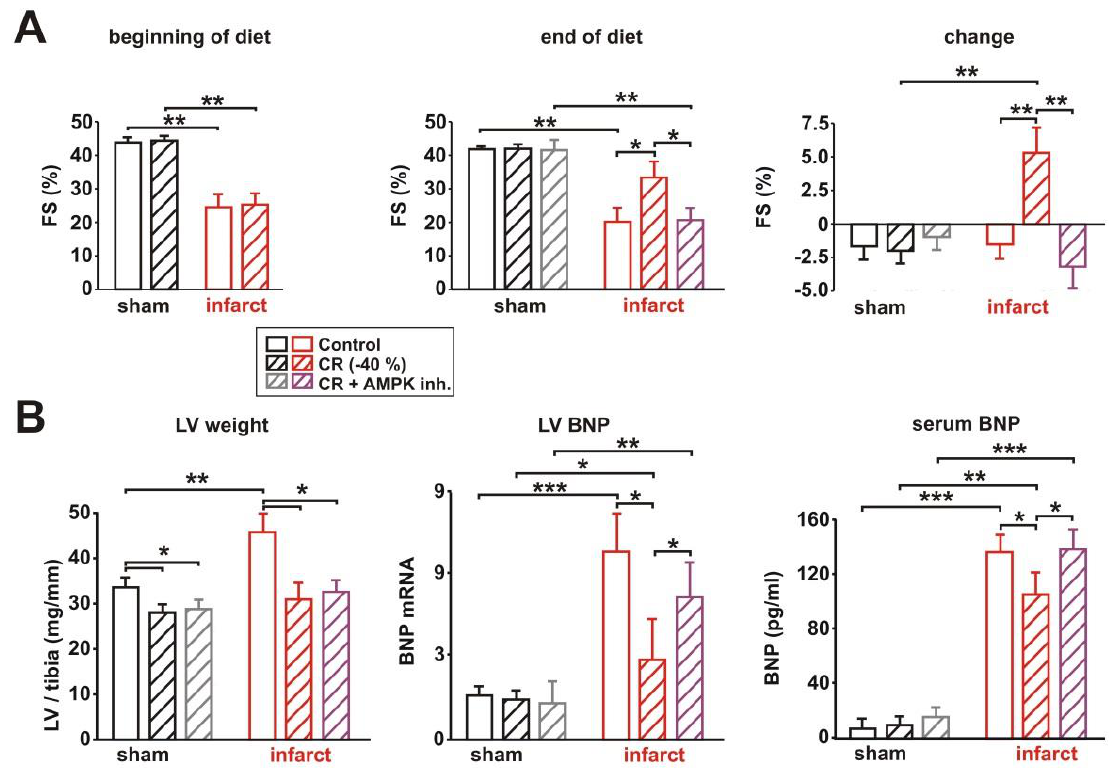
Figure 4. Effect of 8 weeks CR and 2 weeks of AMPK inhibition on LV systolic function, LV weight and expression or release of BNP. ( A ): LV fractional shortening (FS%) at the beginning of the diet (left panel), end of the diet (middle panel), and changes in FS during the feeding period (right panel) in sham or infarct rats, following 8 weeks of control or CR diets. ( B ): LV weight normalized to tibia length at the end of the study (left panel), LV mRNA expression (middle panel), and serum levels of brain natriuretic peptide (right panel) in sham or infarct rats following 8 weeks of control or CR diets. All data are mean ± SEM. n = 6-7 animals per group, *: p < 0.05; **: p < 0.01; ***: p < 0.001.